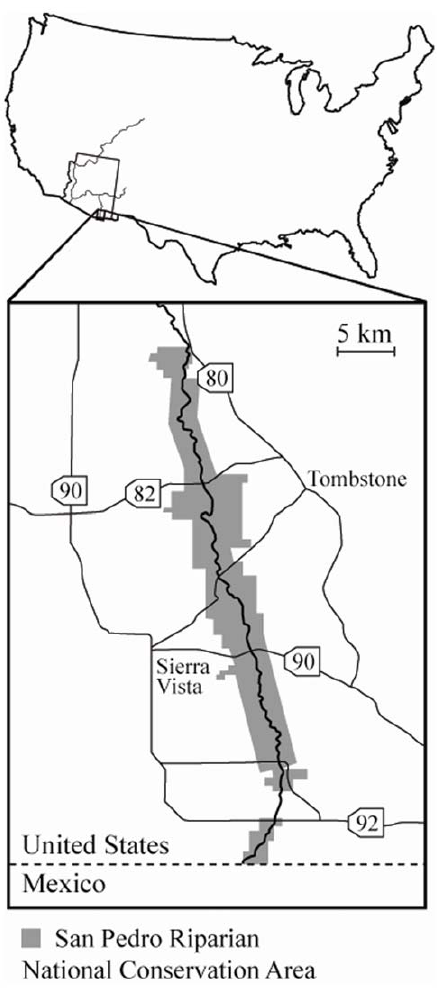
Figure 1. Map of the upper San Pedro River. The river is located in the Chihuahuan Desert of southeastern Arizona, USA. Note the extent of the San Pedro Riparian National Conservation Area, shaded gray.